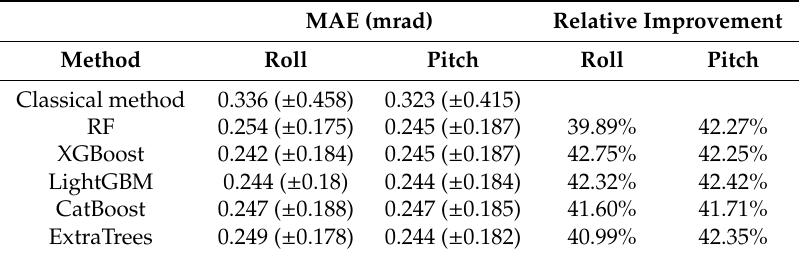
Table 5. CA narrow range errors after 3 s of prediction time for 0.01 ◦ train set resolution. MAE